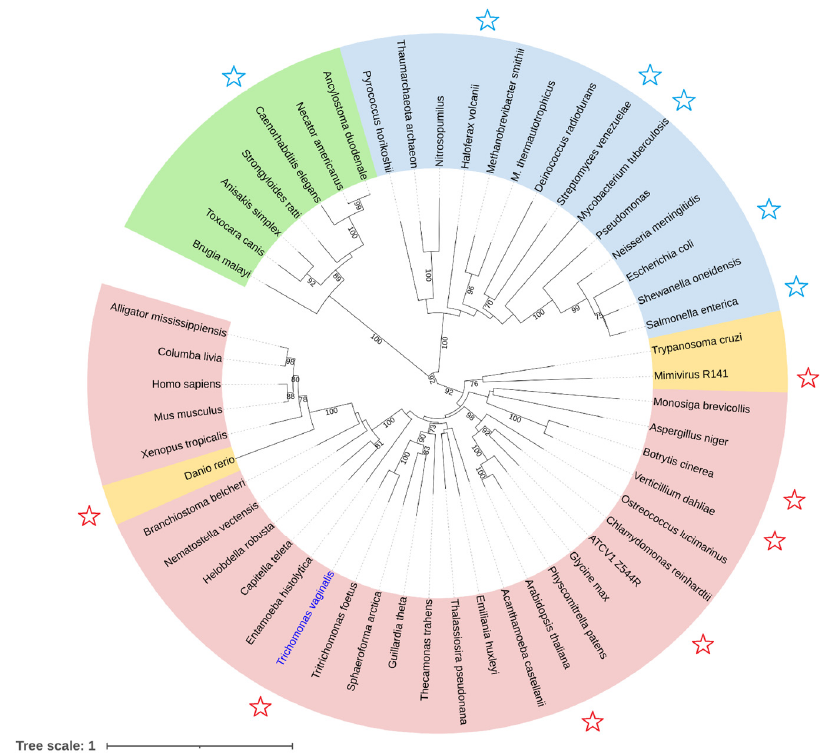
Figure 6. Phylogenetic analysis of representative NDP-D-Glc 4,6-dehydratases from different taxa. Sequences displaying specific residues in the position corresponding to TvUGD His214 are indicated by different colors: Met, green; Tyr, blue; Gln, orange; His, red. Blue stars indicate characterized enzymes that use dTDP-D-Glc, while red stars are used for the proteins showing a clear preference for the UDP-bound substrate. Details of the sequences used for analysis are reported in Supplementary Table S1. TvUGD is highlighted in blue.